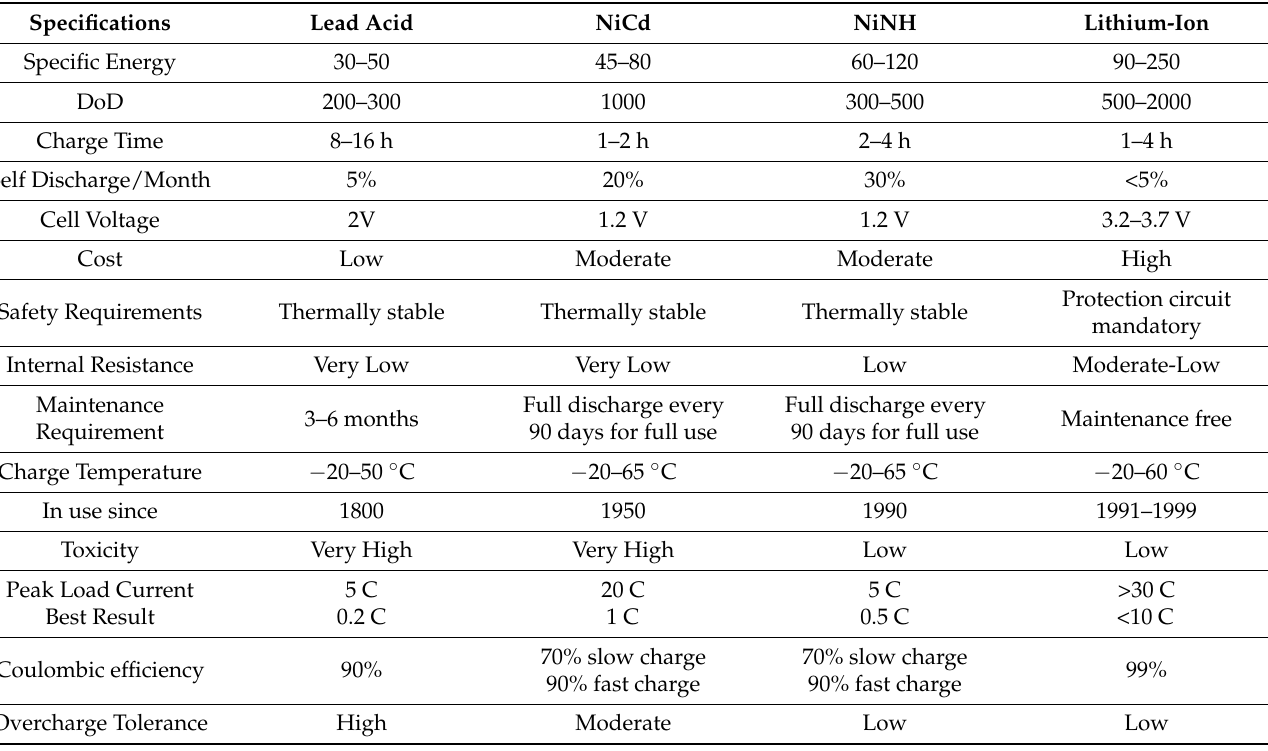
Table 7. Characteristics of basic types of batteries